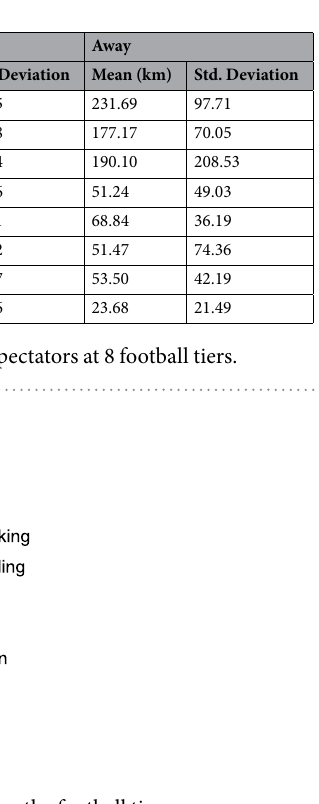
Figure 1. Participants’ percentage mode of travel across the football